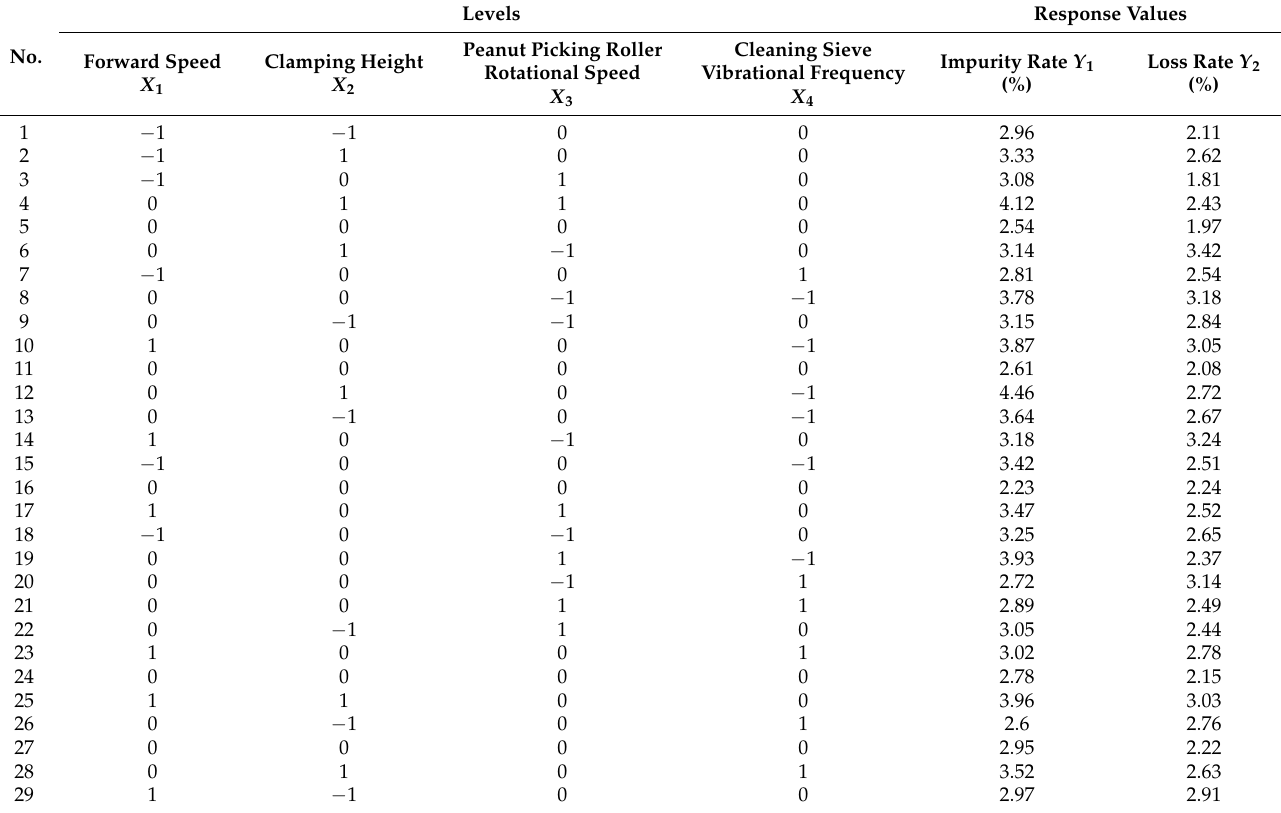
Table 3. Experimental design and response